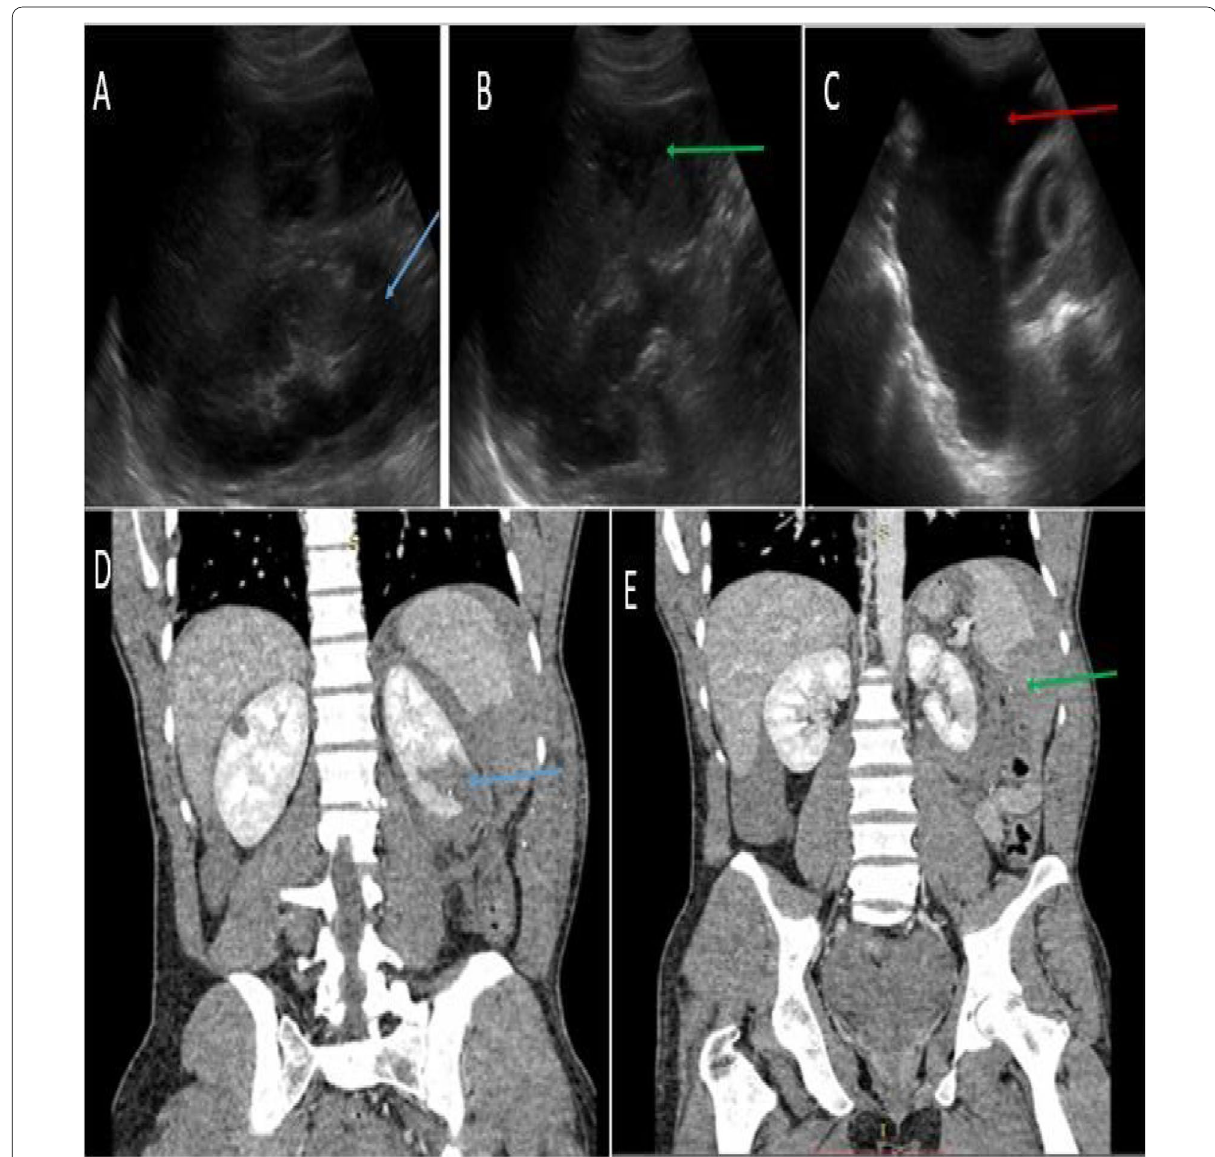
Fig. 2 A 25‑year‑old male patient presented with firearm injury. FAST examination. A Lower pole of the left kidney shows hyperechoic area with irregular border (blue arrow)… left renal contusion . B The lower pole of the spleen shows a heterogeneous area (green arrow)… parenchymal hematoma. C Mild pelvic Intra peritoneal fluid (red arrow). Contrast‑enhanced MDCT. D Coronal reformatted image: an area of decreased enhancement at the lower pole of the left kidney (blue arrow) with perinephric hematoma; renal contusion with perinephric hematoma